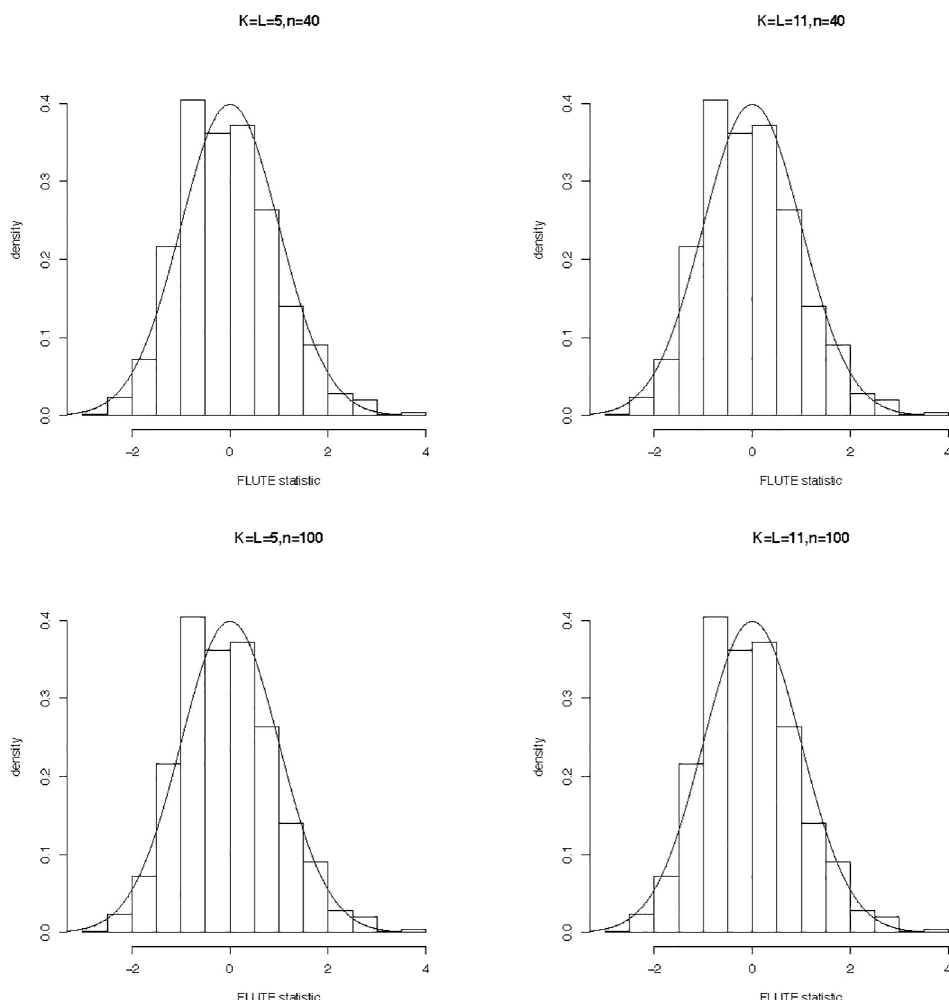
Fig 2. The null distribution of the FLUTE statistic in FLMs with functional responses. The solid line indicates the density of the standard normal